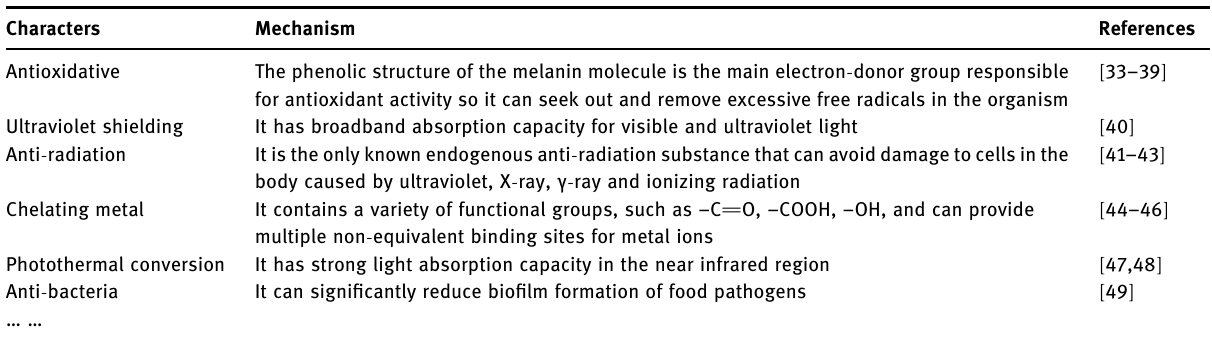
Table 1: Characteristics and related mechanism of